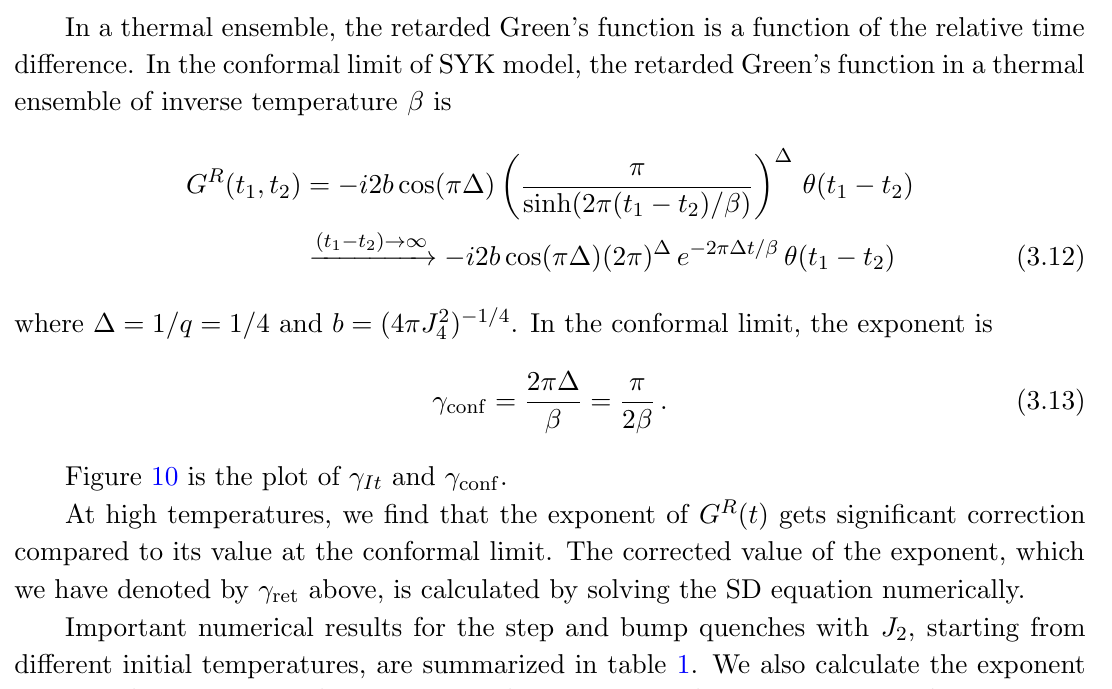
Figure 10 is the plot of (cid:13)